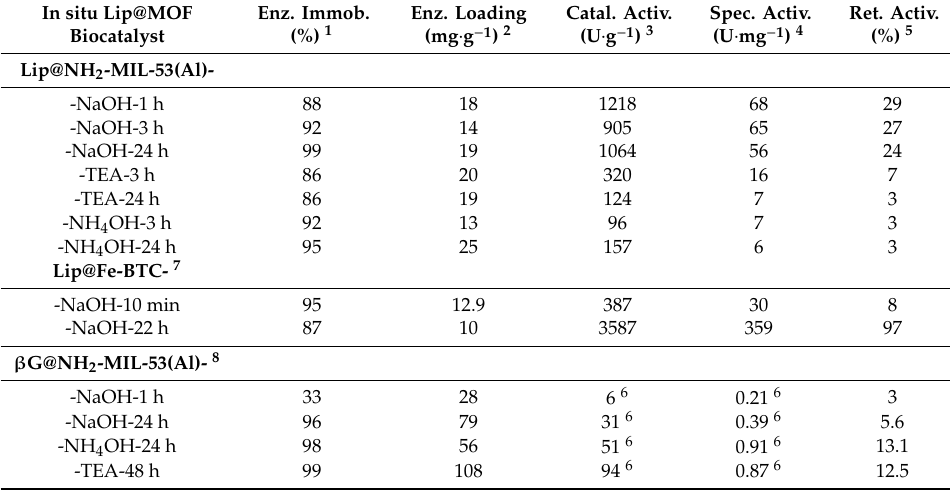
Table 1. Enzyme immobilization percentage, enzyme loading, catalytic activity, specific activity,